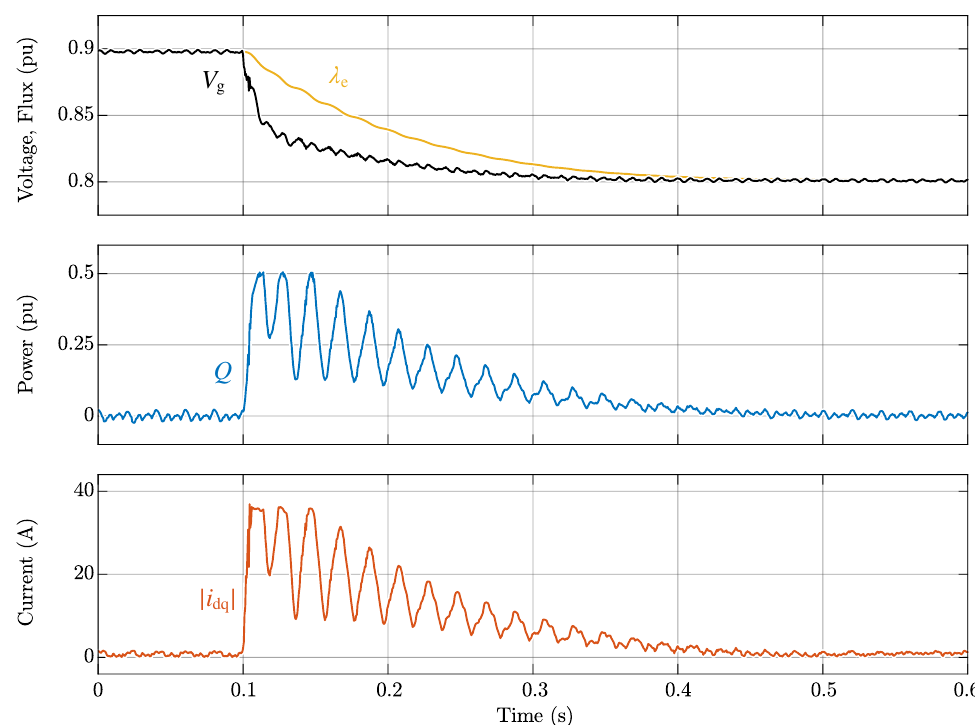
(b) Figure 19. Experimental S-VSC response to a 10% permanent voltage dip: the injected current follows the typical exponential profile of synchronous generators.